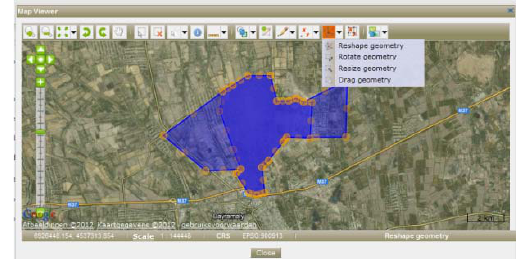
Figure 4: Example of Component Part © Silk Roads